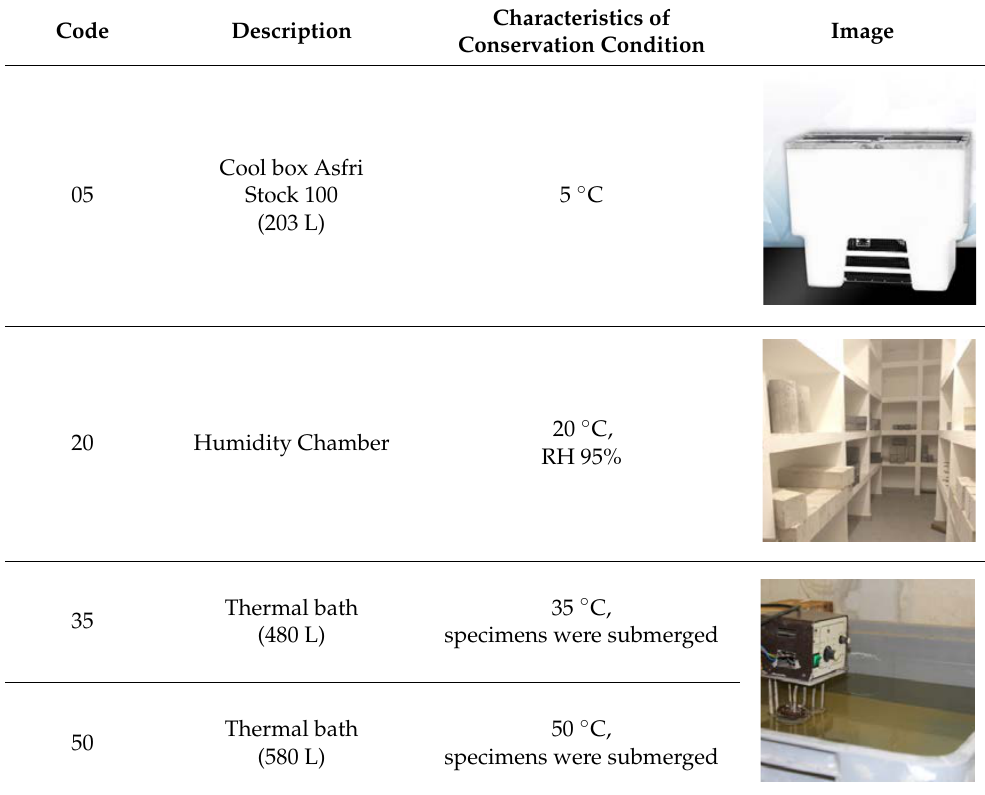
Table 3. The conservation conditions. Figure 3. Summary of the procedure. (*) Conditions described in Table 3; (**) Depending on the specimens.